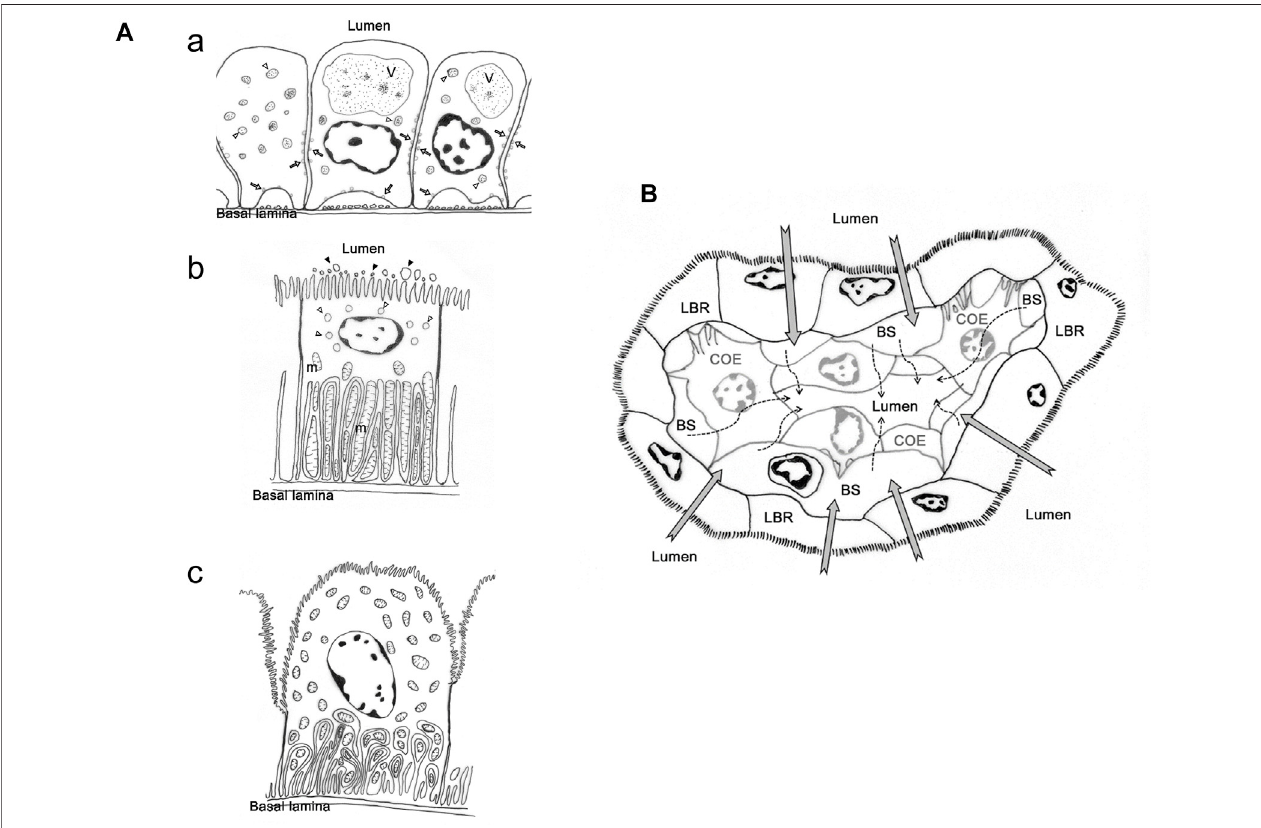
FIGURE 1 | The cell types and presumed urine production and re-absorption process in antennal gland of Ocypode stimpsoni . (A) Three types of cell in antennal gland of O. stimpsoni . Coelomic cells with different size of vesicle (open arrow and triangle) and endosome (V), (a) . Labyrinthine cells have a great of mitochondria (m) in basal folding, vesicles (open triangle) in sub-apical region and aposomes (black triangle) around apical microvilli, (b) . End-labyrinthine cells, another type of labyrinthine cells, showed a different shape of apical membrane compared to labyrinthine cells. In addition, mitochondria not only distributed in basal folding, but also in other regions of end-labyrinthine cells, (c) . (B) Hemolymph will be fi ltrated through coelomic cells (dash arrow), and the ions and other substances will be re-absorbed into hemolymph by labyrinthine cells (grey arrow). COE, coelomic cell. hs, haemolymph sinus. LBR, labyrinthine cell. The fi gure comes from Tsai and Lin, (2014).